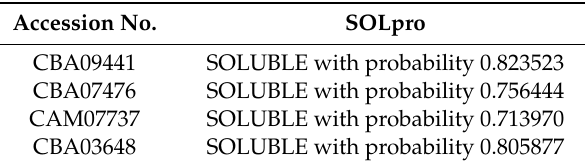
Table 2. Solubility of proteins.